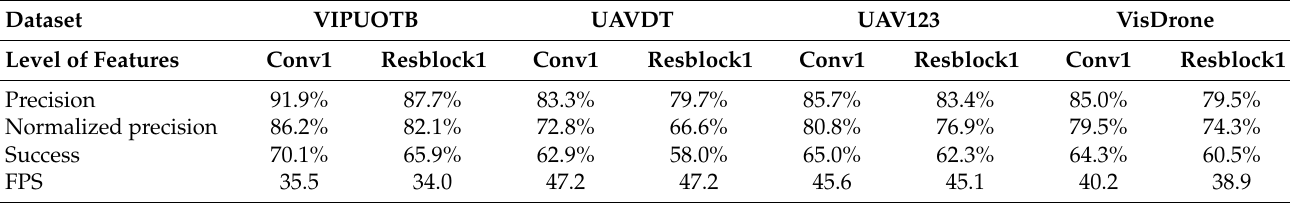
Table 5. The comparison tracking results of utilizing different attention